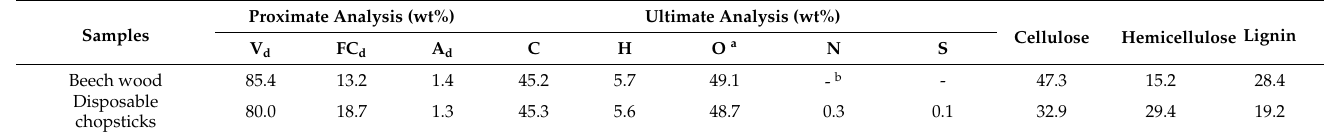
Table 1. Proximate and ultimate analysis on dry basis and three-components of the